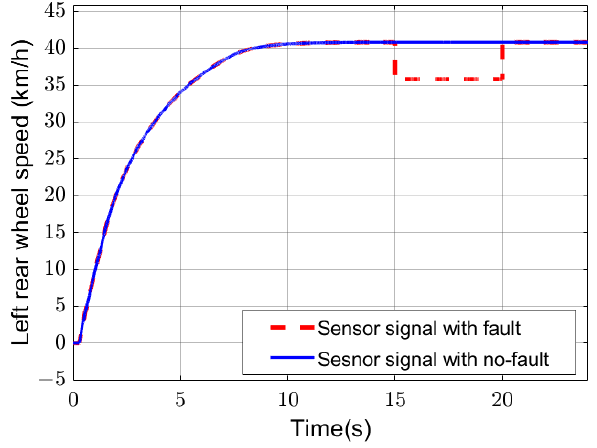
Figure 9. Left rear wheel speed sensor signal (Blue line: sensor signal with no fault; red dotted line: sensor signal with a negative offset fault).